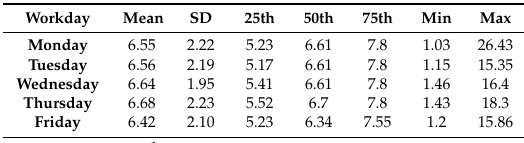
Table 6. Basic statistics of travel speed (m/s) about link 88 1 .